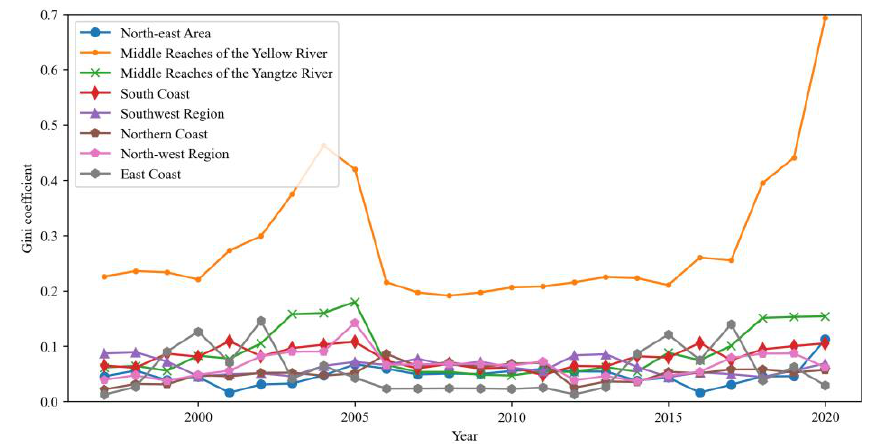
Figure 3. Change trend of Dagum Gini coefficient in different regions.